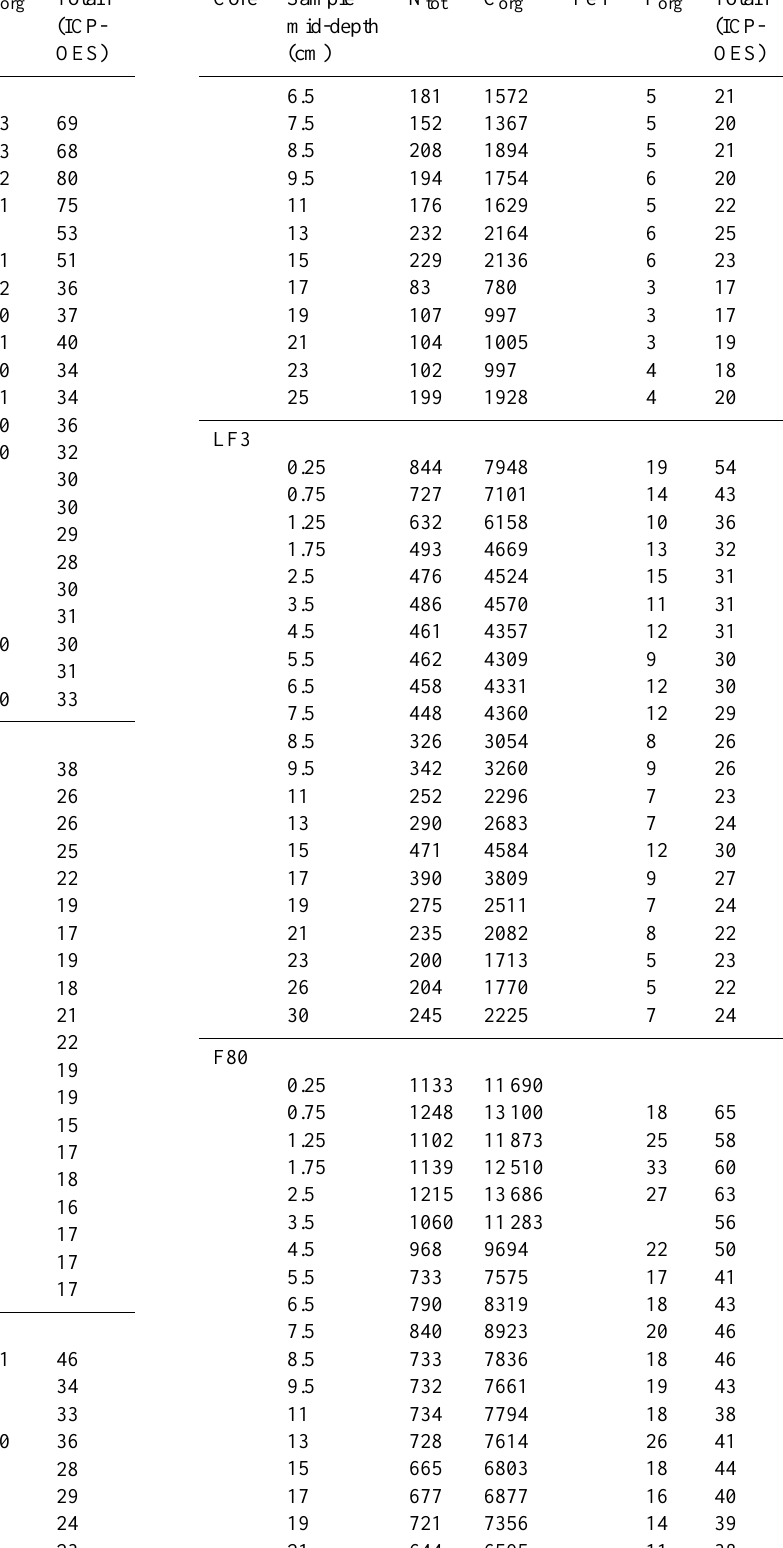
Table B1. Solid-phase parameters, in µmolg − 1 salt-free dry sedi-